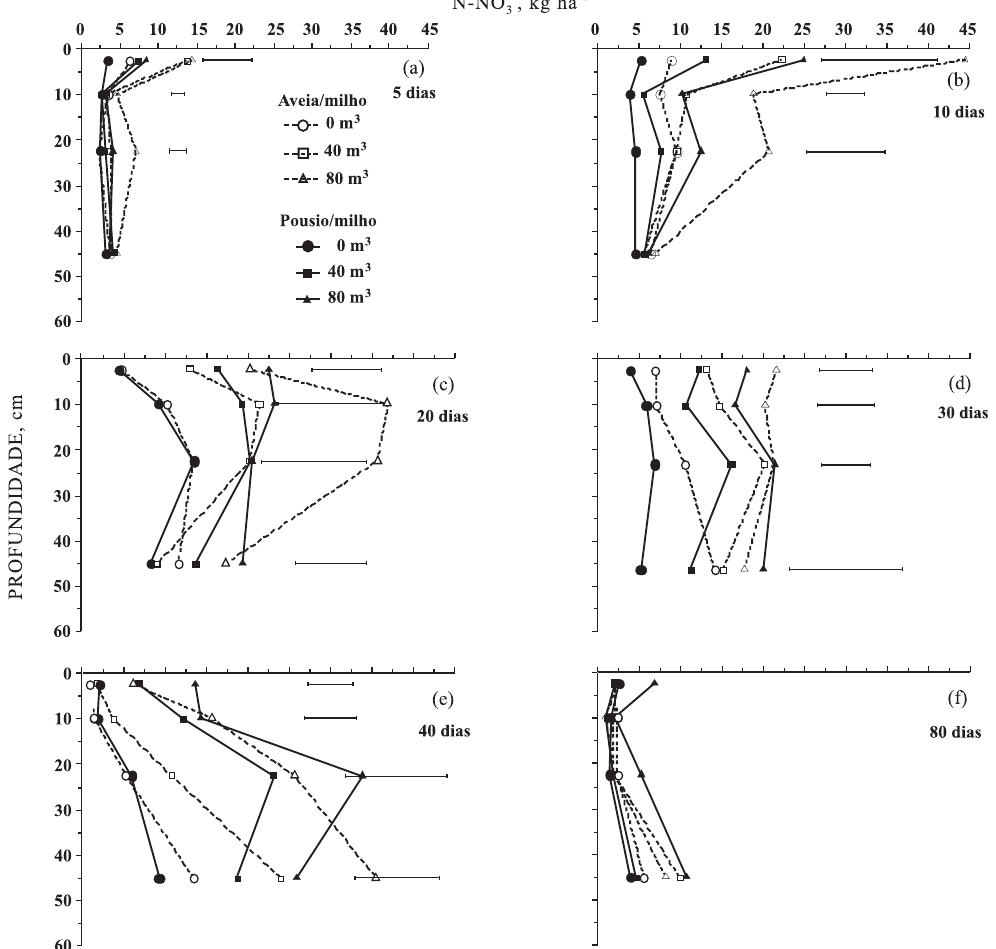
Figura 1. Quantidades de N-NO 3- na camada de 0-60 cm do solo durante o cultivo de milho, aos 5, 10, 20, 30, 40 e 80 dias após a aplicação dos dejetos (0, 40 e 80 m 3 ha -1 ), nos sistemas aveia/milho e pousio/milho nos três anos agrícolas (1998/99, 1999/00 e 2000/01). Nas profundidades em que existem barras horizontais, estas indicam diferença mínima significativa (Tukey a 5